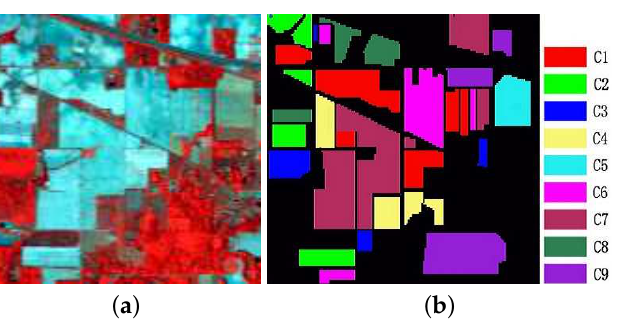
Figure 5. ( a ) False color hyperspectral remote sensing image over the Indian Pines test site (using bands 50, 27, and 17). ( b ) Ground truth of the labeled area with nine classes of land cover: Corn-notill, Corn-mintill, Grass-pasture, Grass-trees, Hay-windrowed, Soybean-notill, Soybean-mintill, Soybean-clean, and